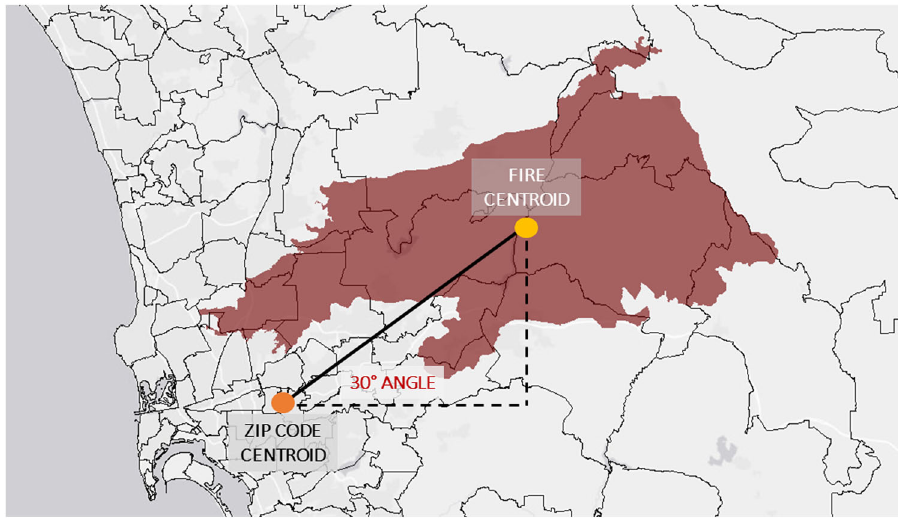
Fig. 4 Wild fi re upwind exposure estimation. The relationship between a given zip code centroid and a fi re centroid is assessed by means of geospatial tools. Fires burning upwind are considered within the context of the north-easterly direction of Santa Ana Winds. We use the distance between centroids, as well as the angle of the spatial relationship as shown here, to classify a zipcode day as exposed (or